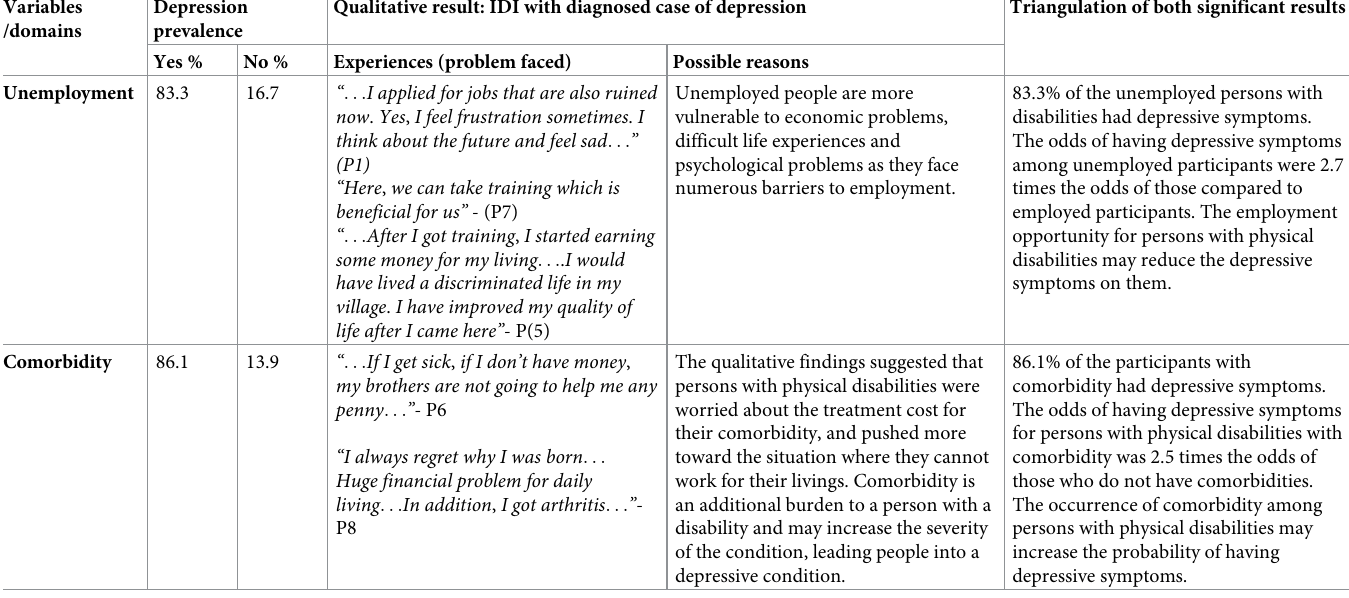
Table 5. Integrated findings of employment status and comorbidity. Variables